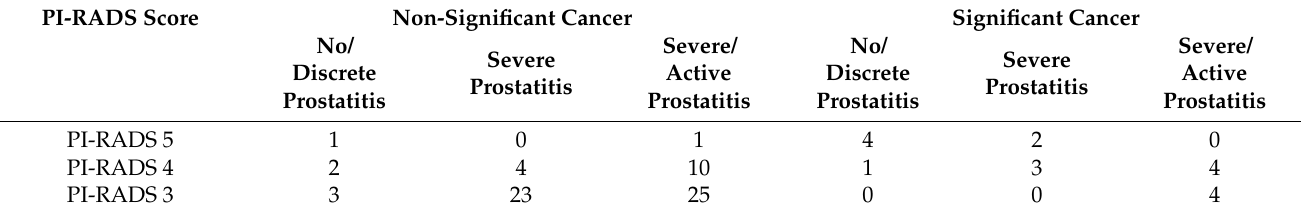
Table 3. Absolute values for the association between PI-RADS scores, prostatitis grade, and non-csPCa/PCa in the peripheral zone. The combination of PI-RADS 3 and severe or active chronic prostatitis was the most common, while clinically significant prostate cancer (csPCa) was rarely detected in this combination. Note that the group sizes for PI-RADS 4 and 5 and no/discrete prostatitis were very small.